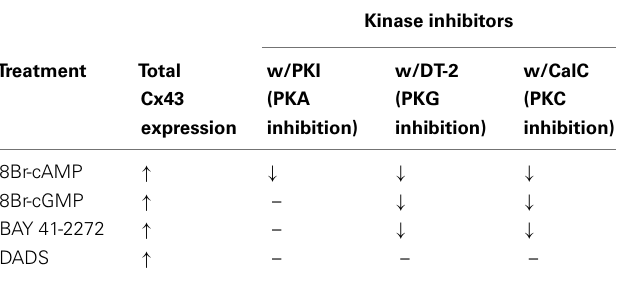
Table 1 |Table showing the summary of the effect of 8Br-cAMP, 8Br-cGMP, BAY, and DADS on Cx43 expression and the regulation of this Cx43 stimulation by the respective